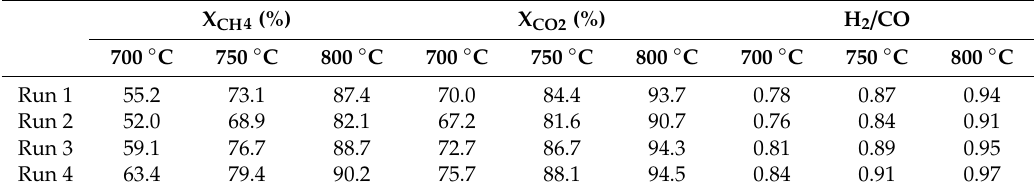
Table 4. Reactants’ conversions and H 2 /CO molar ratios at 700 and 800 °C of four catalytic runs.